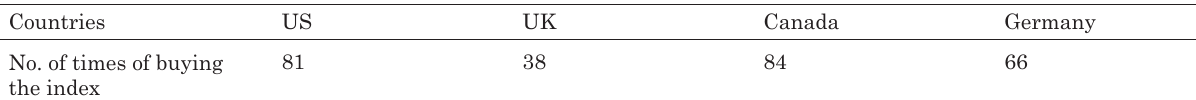
Table 8. No. of times of buying the securitized real estate indices of the four countries when applying the strategy according to the Shiryaev-Zhou index Countries US